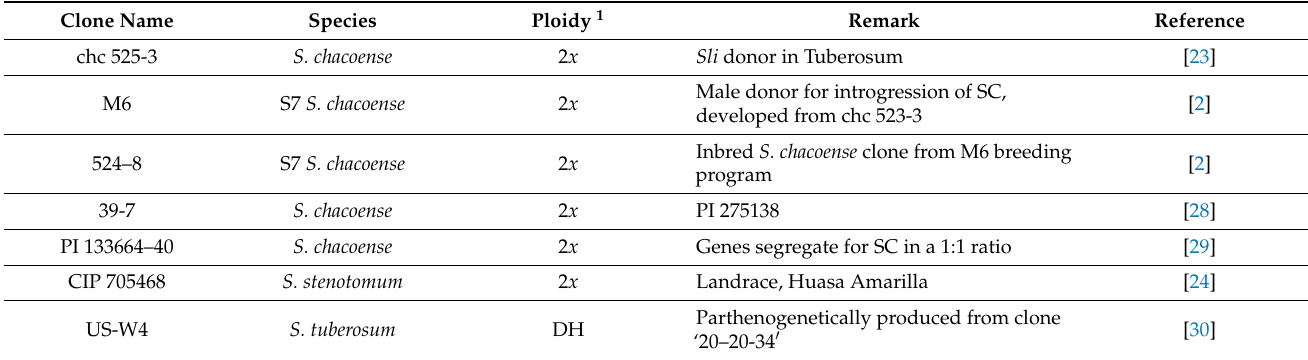
Table 1. Self-compatible clones used to date to explain self-compatibility in diploid